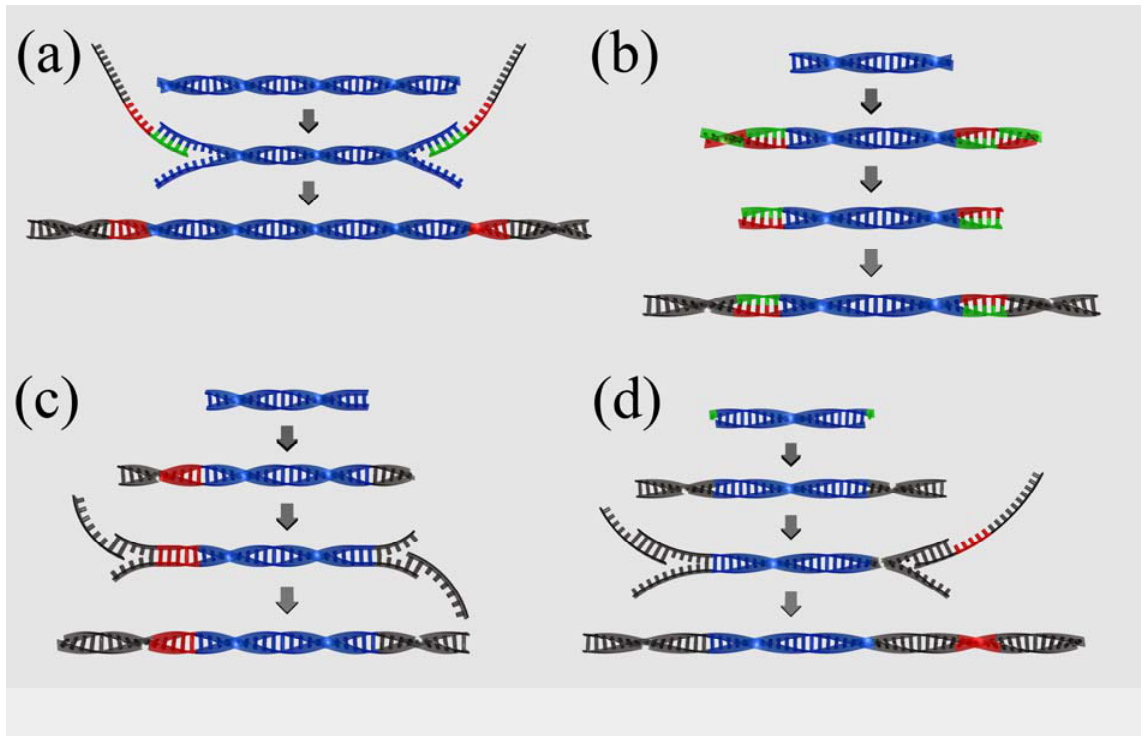
Figure 2. Comparison of barcoding strategies. (a) Fusion primers (454): Target molecules (blue) are amplified with primers consisting of target specific priming site (green), barcode (red) and 454 specific adapter sequence (grey). (b) Parallel tagged sequencing (PTS): Palindromic barcodes (red/green) are blunt end ligated to the ends of target molecules (blue). The outer half of the barcoding adapter ( i.e. , the reverse complement part) is removed by restriction digest. Sequencing adapters (grey) are blunt end ligated to the ends of the barcoding adapters. (c) Direct multiplex sequencing (DMPS): One truncated, barcoded adapter (red and grey) and one truncated standard adapter (grey) are blunt end ligated to the ends of target molecules (blue). Adapters are extended to full length by PCR amplification with sequencing adapter specific primers. (d) Illumina barcoding (simplified): Truncated Illumina adapters (grey) are cohesive-end ligated to template molecules (blue) with adenine overhangs (green). Adapters are extended to full length by PCR amplification with sequencing adapter specific primers. One of the primers contains the barcoding sequence